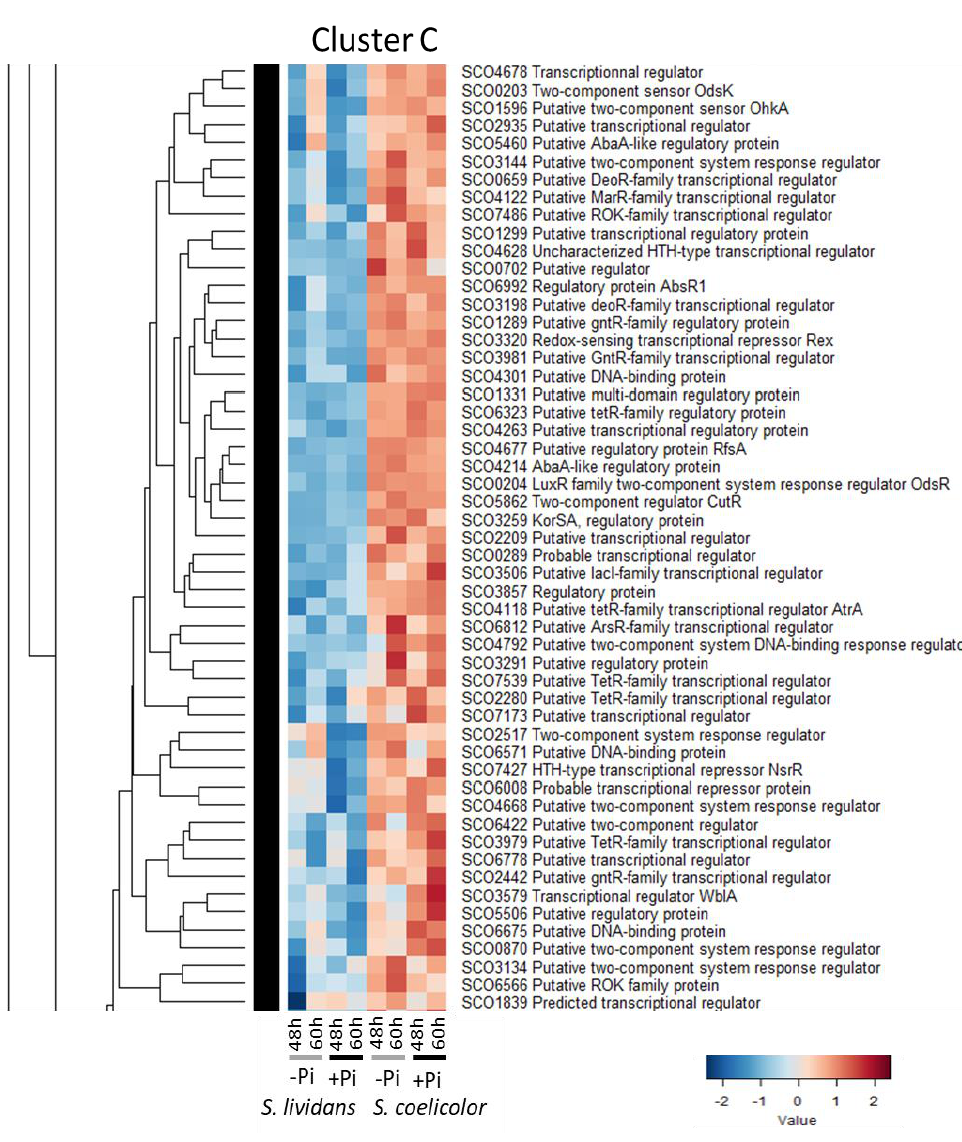
Figure 4. Cluster C, heatmap representation of transcriptional regulators and sensory histidine kinases more abundant in SC than in SL in both Pi conditions.